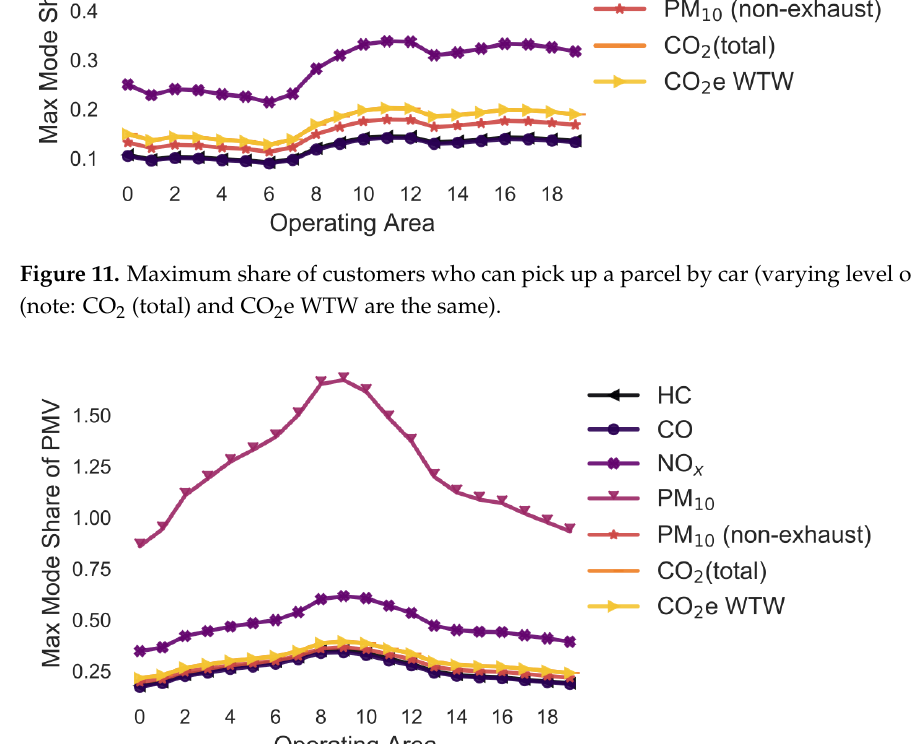
Figure 12. Maximum share of customers who can pick up a parcel by car (varying level of service for home delivery and customer trips).